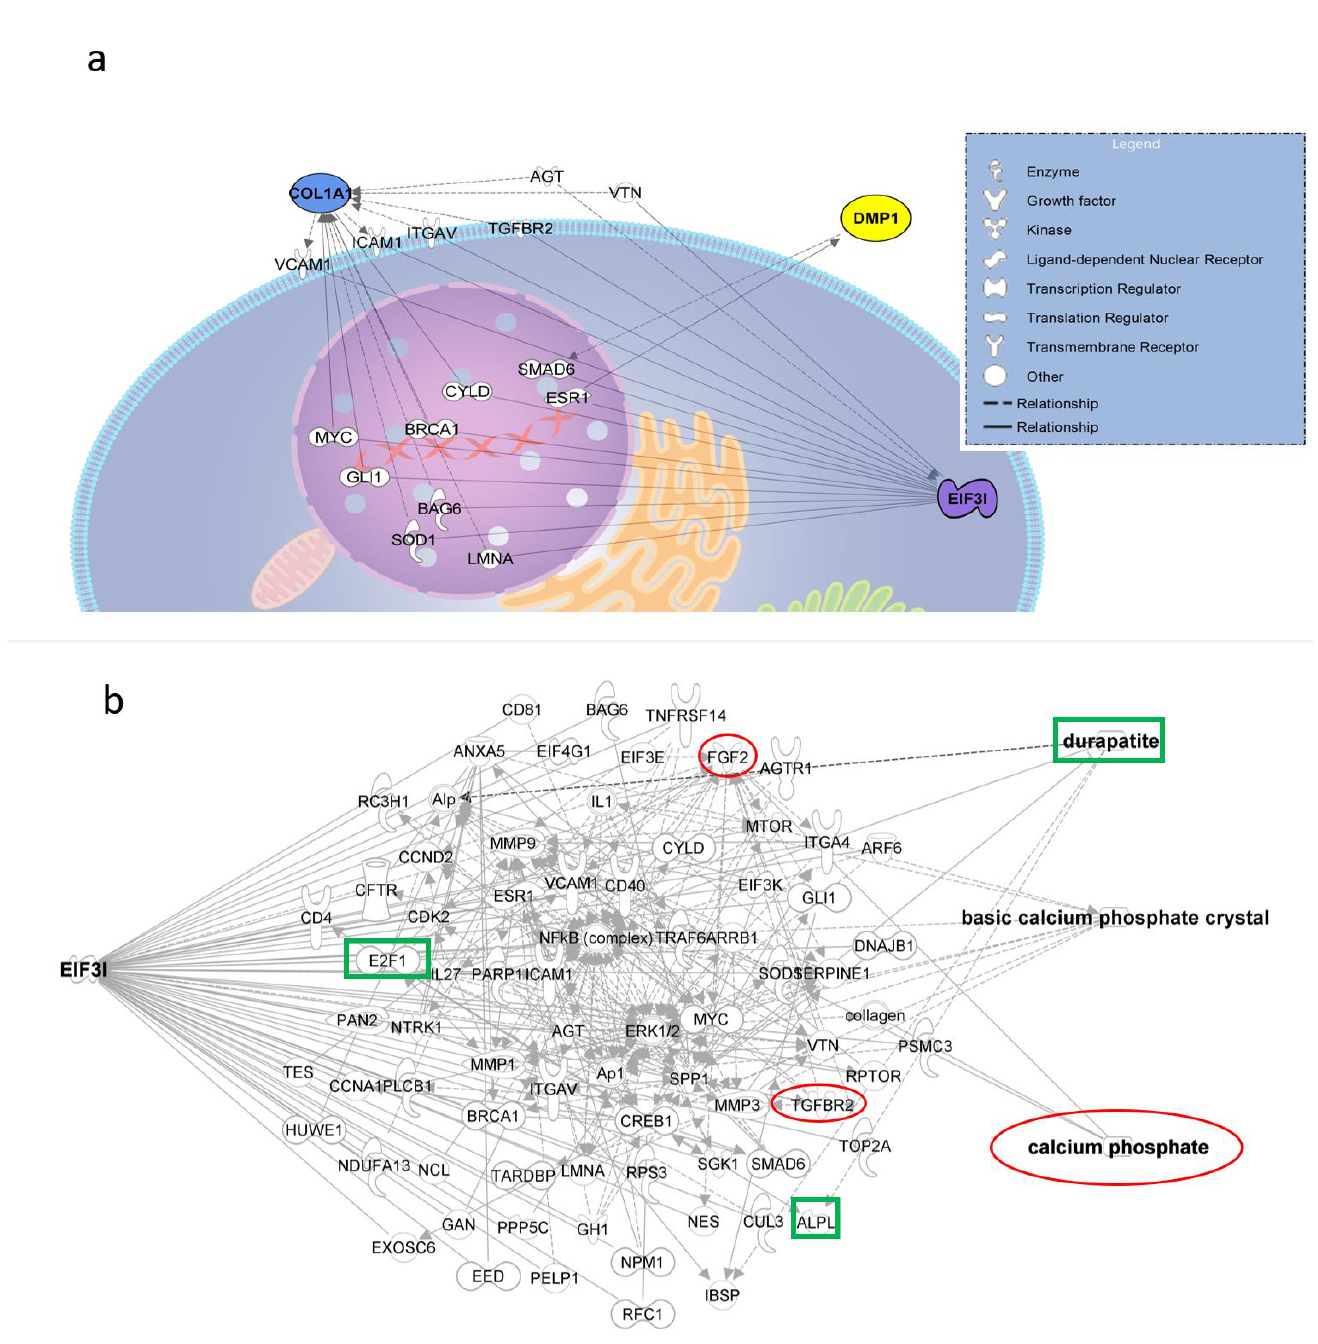
Figure 4. Network plot generated using IPA. ( a ) Molecular network analysis showing the interactions between DMP-1, TRIP-1, and Col1A1 using Ingenuity Pathway Analysis (shortest path with one intermediate node), for example, ‘Col1A1–BRCA1–TRIP-1’ and ‘DMP-1–SMAD6–TRIP-1’. ( b ) Interaction of TRIP-1 with Durapatite (hydroxyapatite), calcium phosphate, and basic calcium phosphate crystal (shortest path with two intermediate nodes). Examples: ‘TRIP-1–TGFBR2–FGF2–calcium phosphate’ and